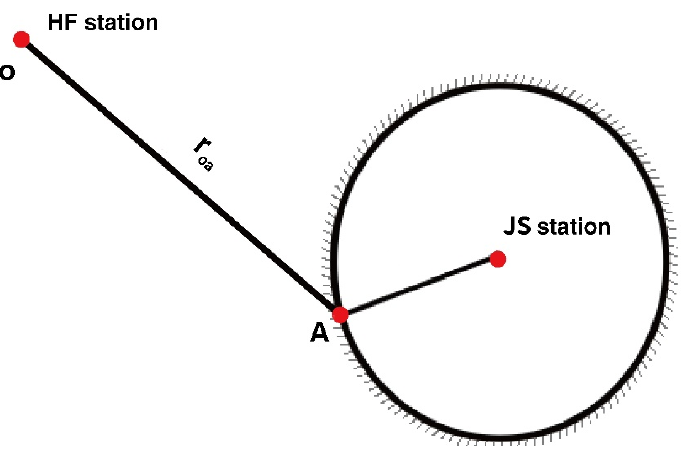
Figure 2. Geometric layout for using two measurement stations to investigate the peak value attenuation function with propagation distance. HF station and JS station are lightning observation stations. r oa is the distance between point O and point A.